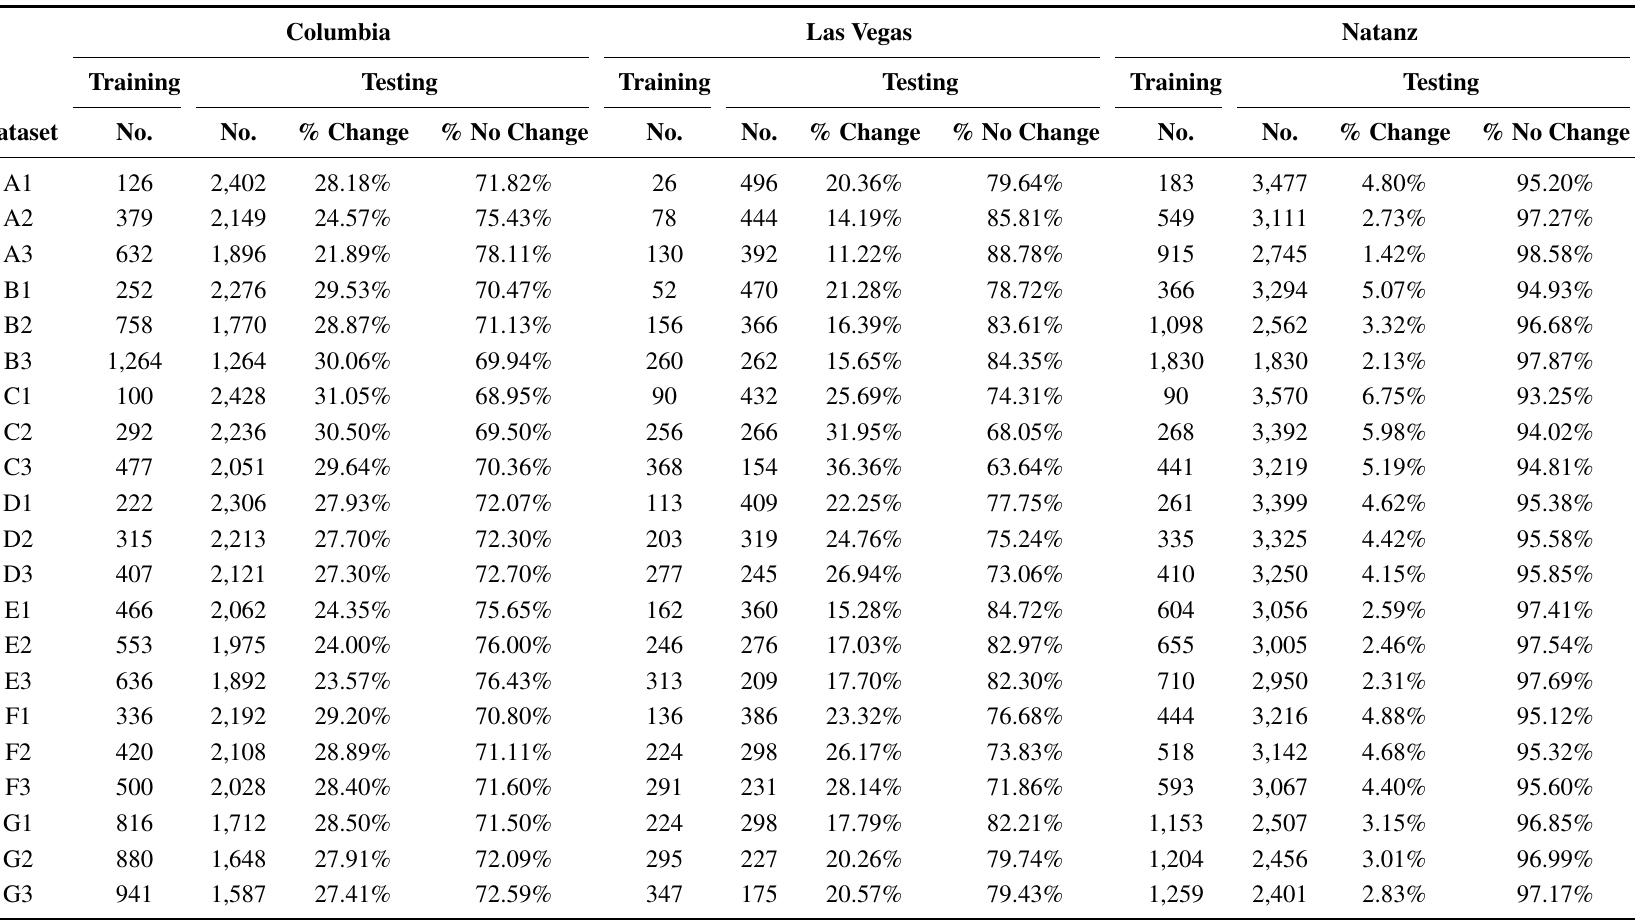
Table 2. Size of training dataset versus testing